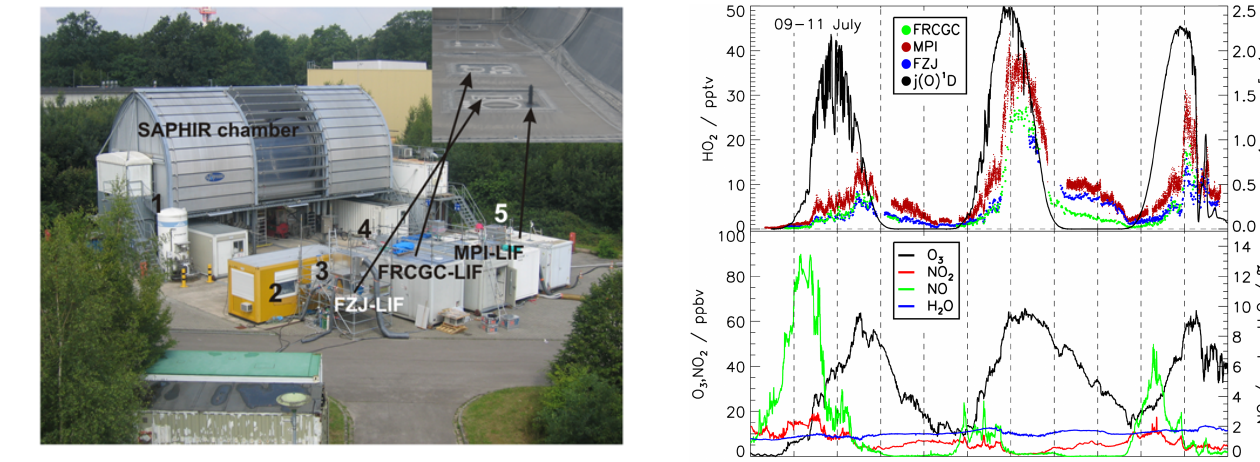
Fig. 1. Location of instruments during the HOxCOMP campaign during ambient air sampling (labels in large photograph) and in- strument inlets during SAPHIR experiments (arrows pointing to positions in the small photograph). Containers of MPI-LIF and FRCGC-LIF were moved underneath the chamber for SAPHIR ex- periments. HO 2 data in this work were delivered by FRCGC-LIF, MPI-LIF and FZJ-LIF. Numbers indicate positions of instrument inlets measuring: (1) NO x , O 3 , HCHO, VOC, H 2 O, CO (red sign: ambient measurements, green sign: SAPHIR measurements); (2) temperature, relative humidity, HONO; (3) ultrasonic anemometer; (4) filter-radiometer; (5) O 3 .